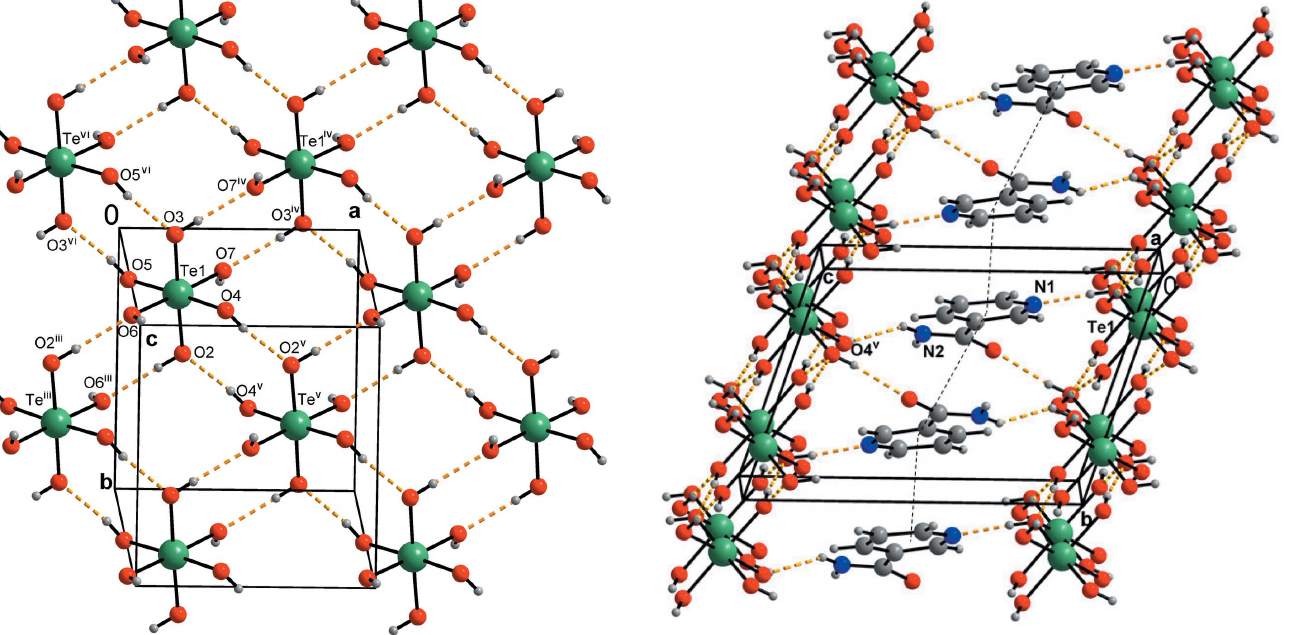
Figure 3 View ( DIAMOND ; Brandenburg & Putz, 2005) of a sheet composed of H 6 TeO 6 molecules only. H, O and Te atoms are represented by small grey, red and green circles, respectively. Hydrogen bonds are shown as yellow dashed lines. Symmetry codes as in Table